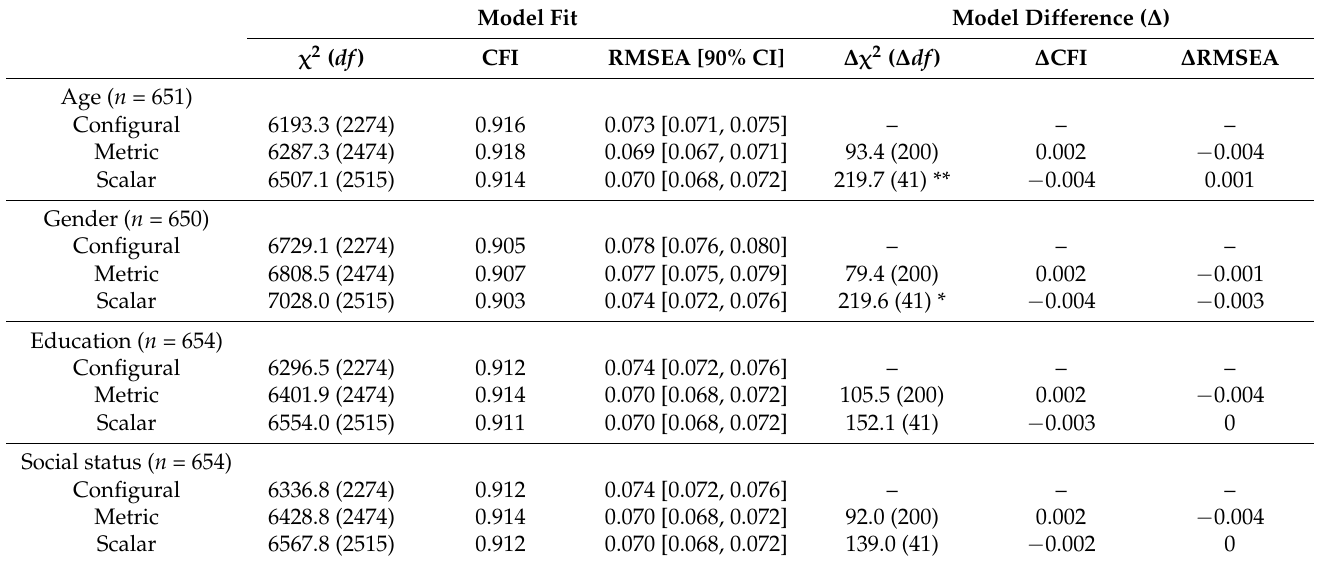
Table 2. Results of a measurement invariance analysis across age, gender, education, and social